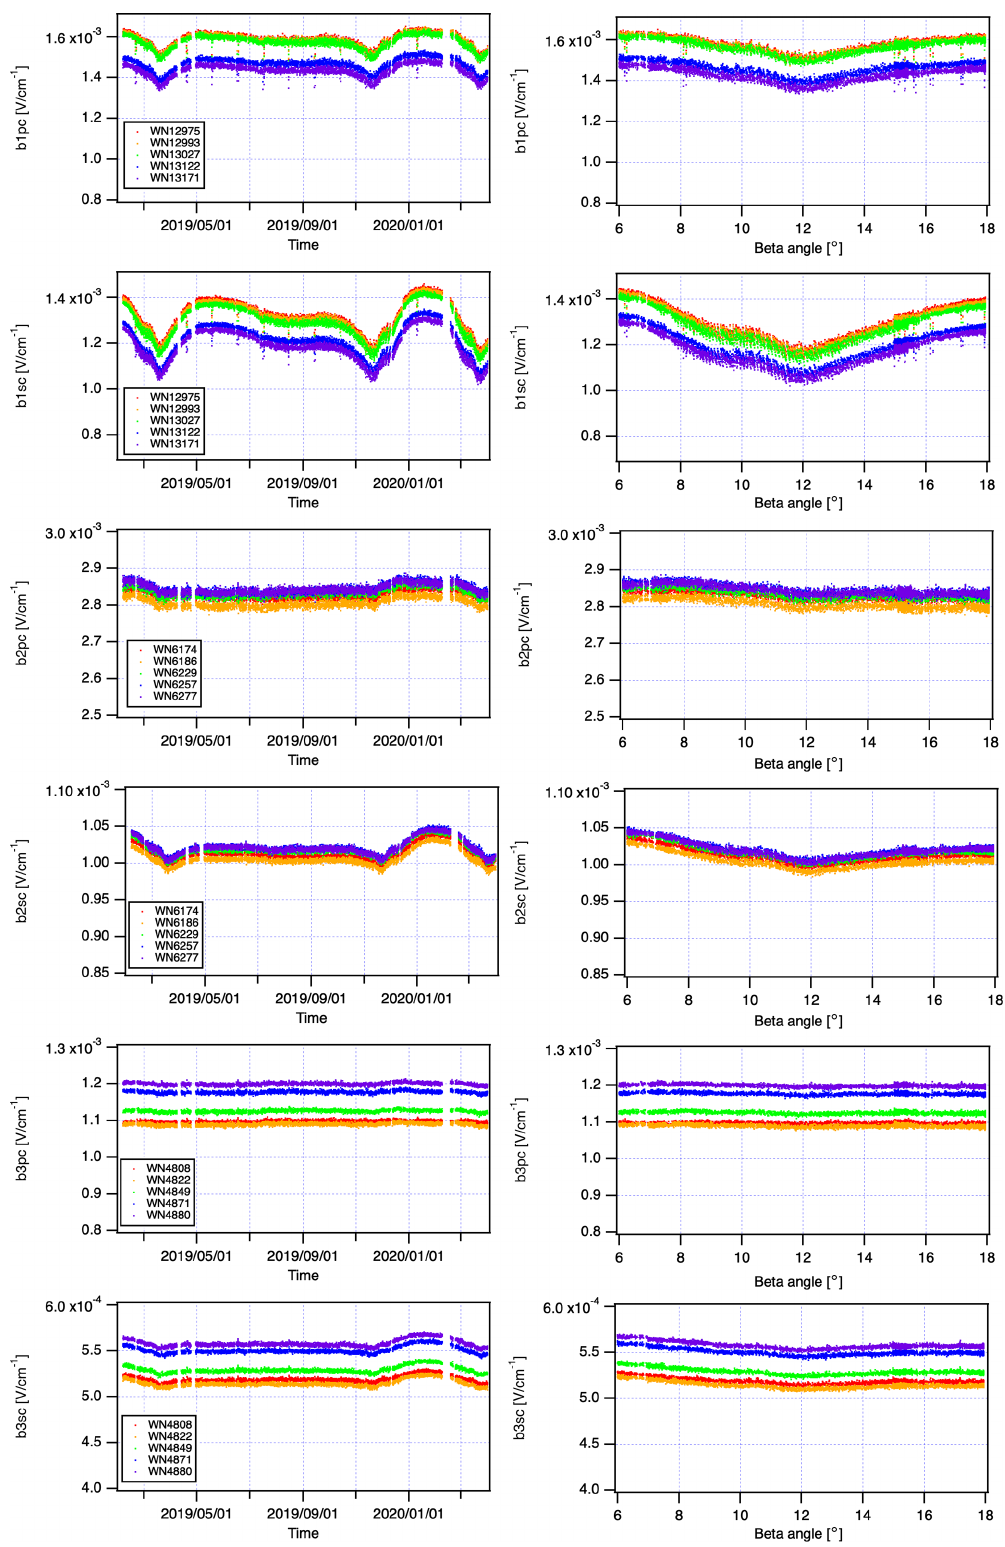
Figure 11. Compensated diffused solar signal level for SWIR region: left panels, time dependency; right panel, beta-angle dependency.